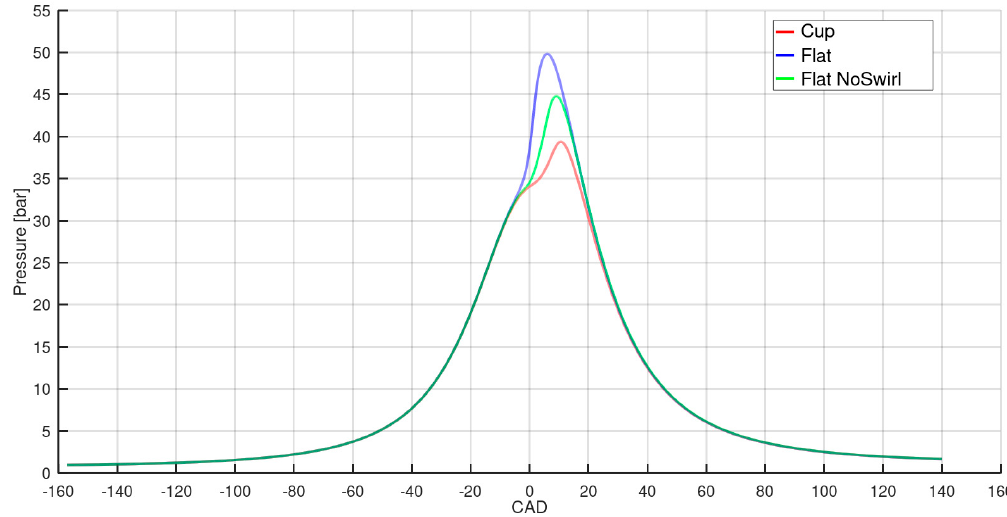
Figure 19. Pressure profiles for the three cases.